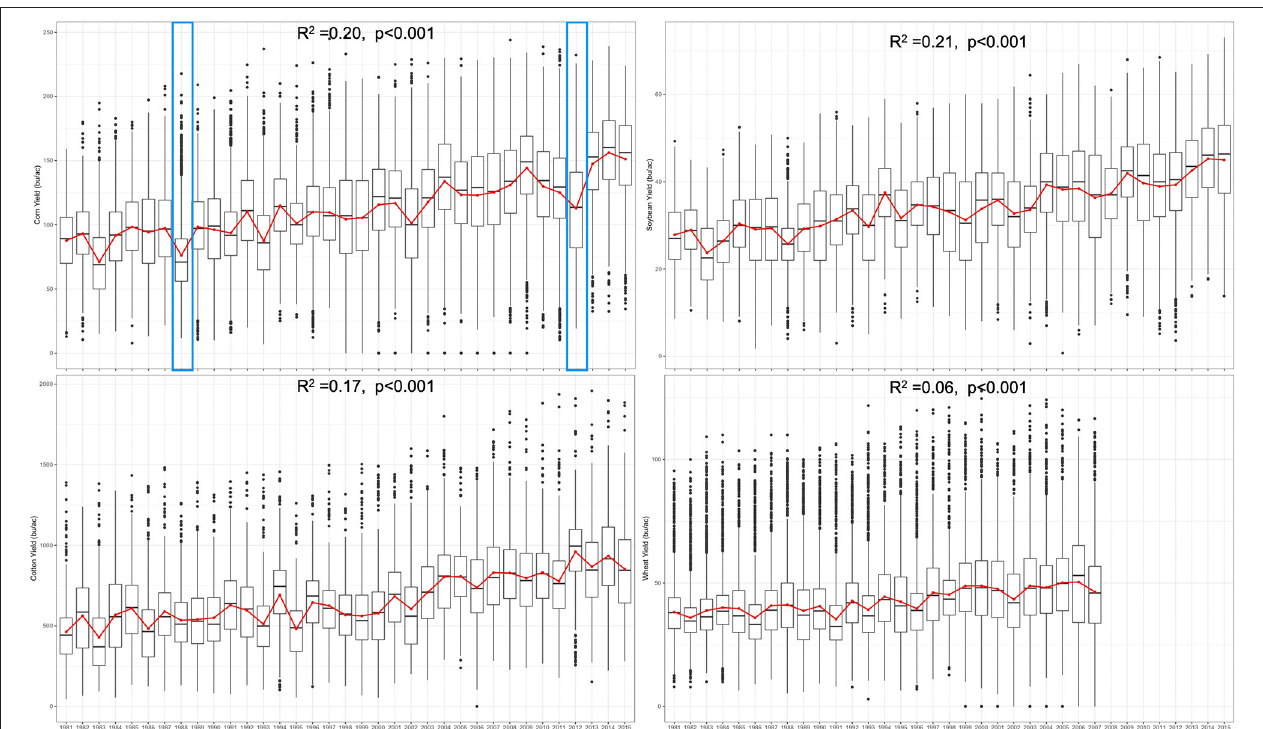
FIGURE 1 | Temporal trends of (a) crop (corn, soybean, cotton, wheat) yields in the ACDC (Agro Climatic Data by County)